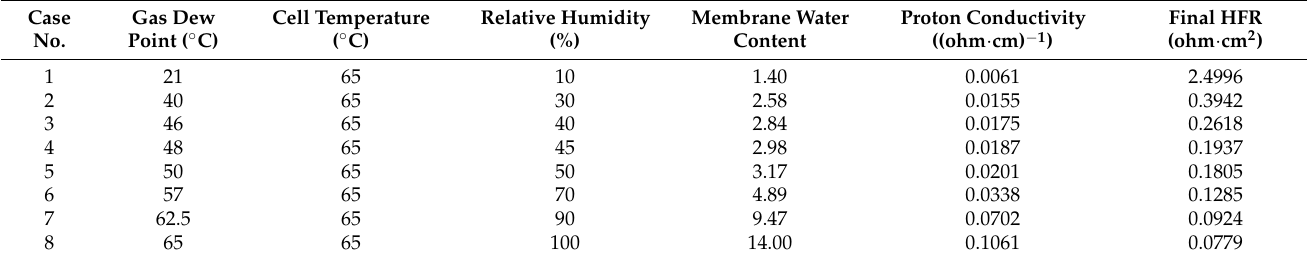
Table 1. Experimental conditions and results for equilibrium purge.